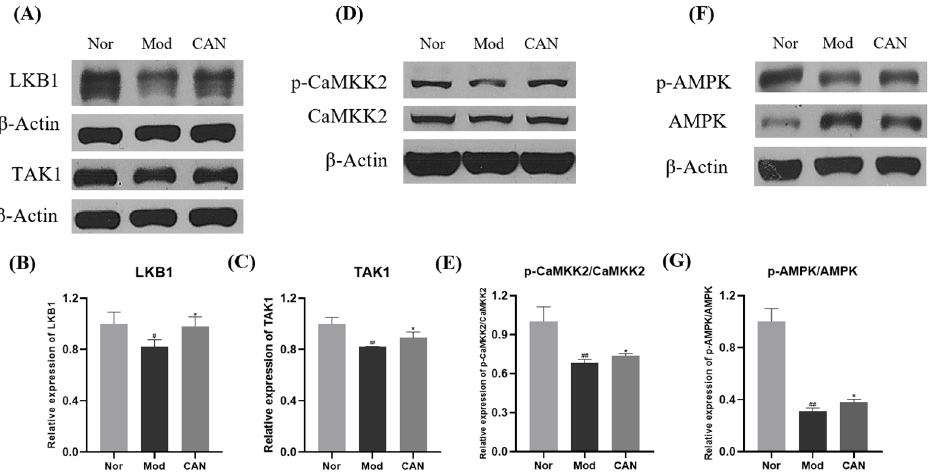
Figure 6. Canagliflozin promotes AMPK activation through upregulating LKB1, TAK1, and p- CaMKK2. HL-1 cells were stimulated with 0.1 mM PA for 24 h in the presence or absence of CAN (5 µ g/mL), and the whole cell lysates from HL-1 cells were used for Western blotting analysis. ( A – C ) Effects of CAN on LKB1 and TAK1 in HL-1 cells. ( D – G ) Effects of CAN on the ratios of p- CaMKK2/CaMKK2 and p-AMPK/AMPK in HL-1 cells. Nor, normal control group; Mod, untreated PA control group; CAN, CAN-treated PA group. Data were expressed as mean ± SD ( n = 3). Differences were considered significant at p < 0.05 and highly significant at p < 0.01 (# p < 0.05, ## p < 0.01 vs. Nor; * p < 0.05 vs.